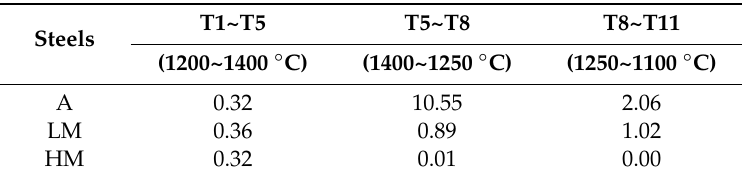
Figure 11. Change in the average austenite grain size with the increase of high-temperature residence time. Table 2. The growth rate of austenite grains at the high-temperature stage of the HAZ thermal cycle ( μ m/s).